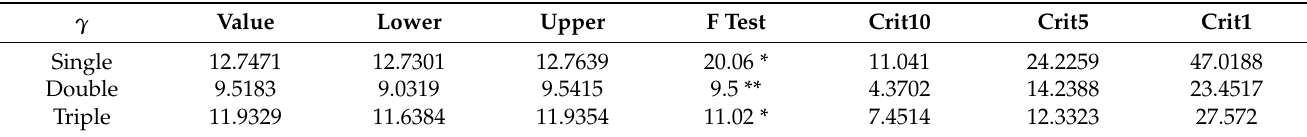
Table 4. Results of the threshold effect model